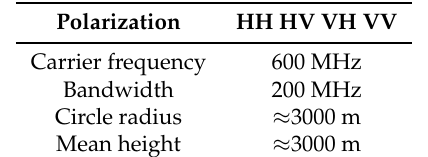
Table 1. Experimental parameters [4].